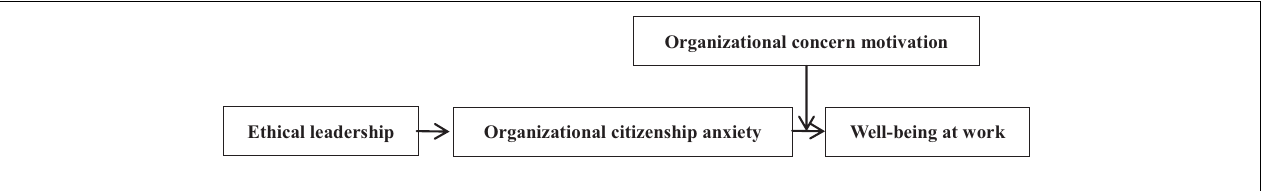
FIGURE 1 | Theoretical